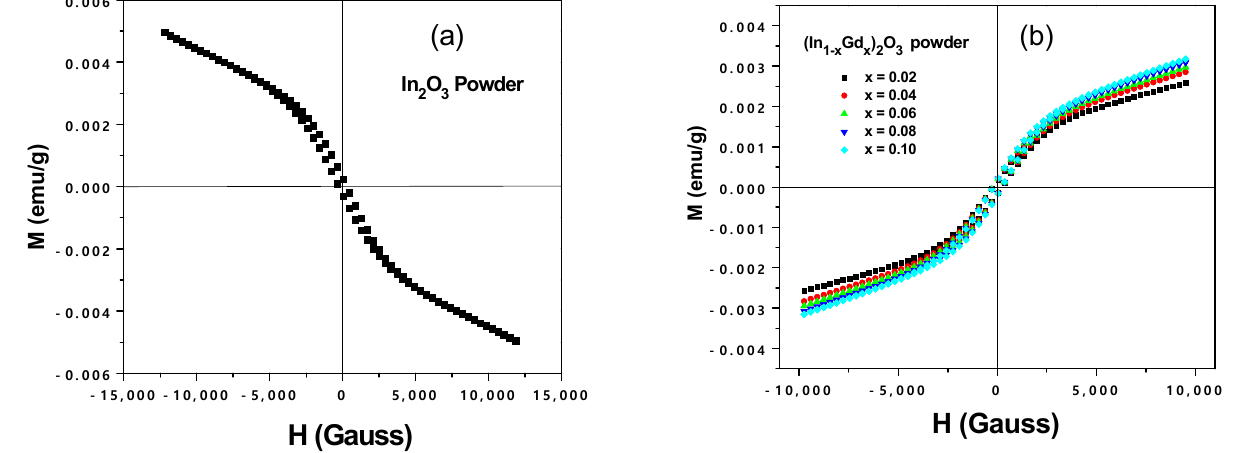
Figure 15. Magnetic hysteresis loops of ( a ) In 2 O 3 and ( b ) (In 1 − x Gd x ) 2 O 3 (x = 0.02, 0.04, 0.06, 0.08, and 0.10) powders at room temperature.